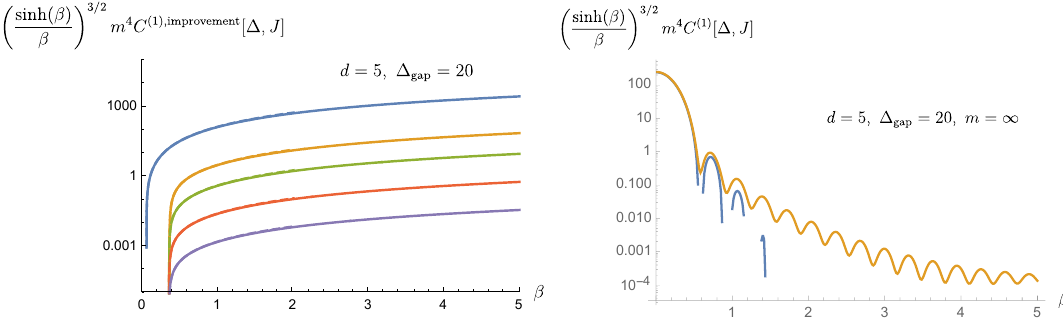
; dashed lines, almost 0